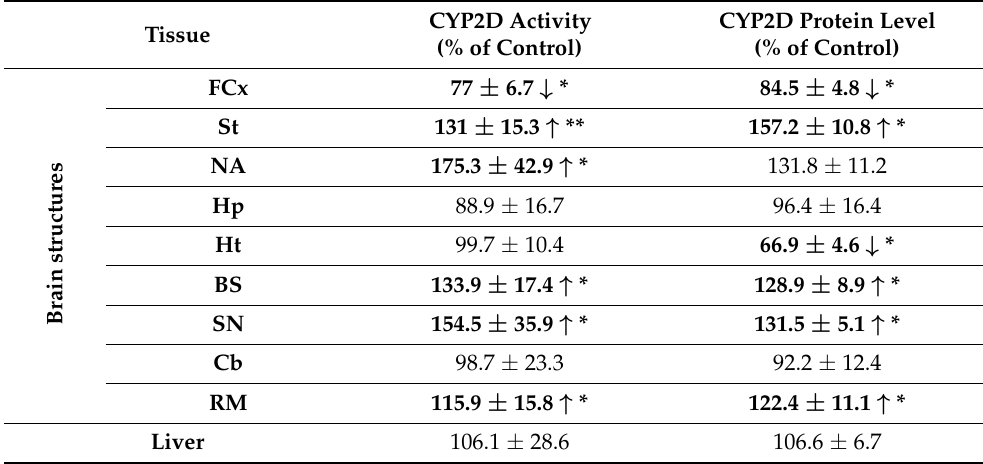
Table 1. The CYP2D activity and protein level after lurasidone treatment in the brain structures and